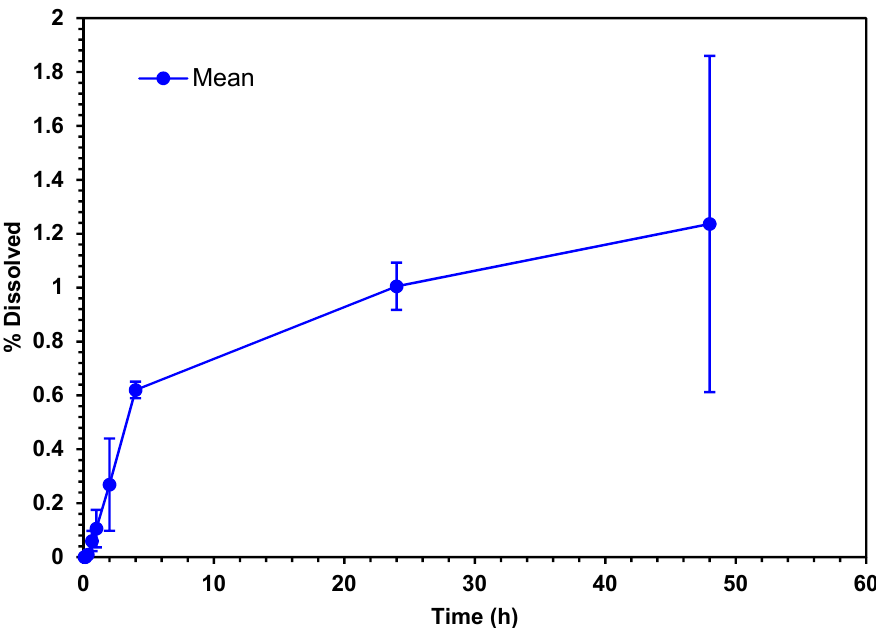
Figure 12. Drug release profiles of the optimized formulation of MA/EA NPs in dialysis tubing bags.